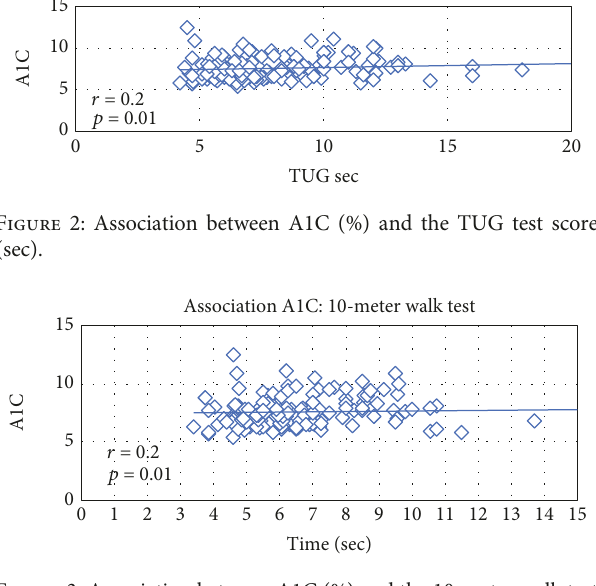
Figure 3: Association between A1C (%) and the 10-meter walk test score